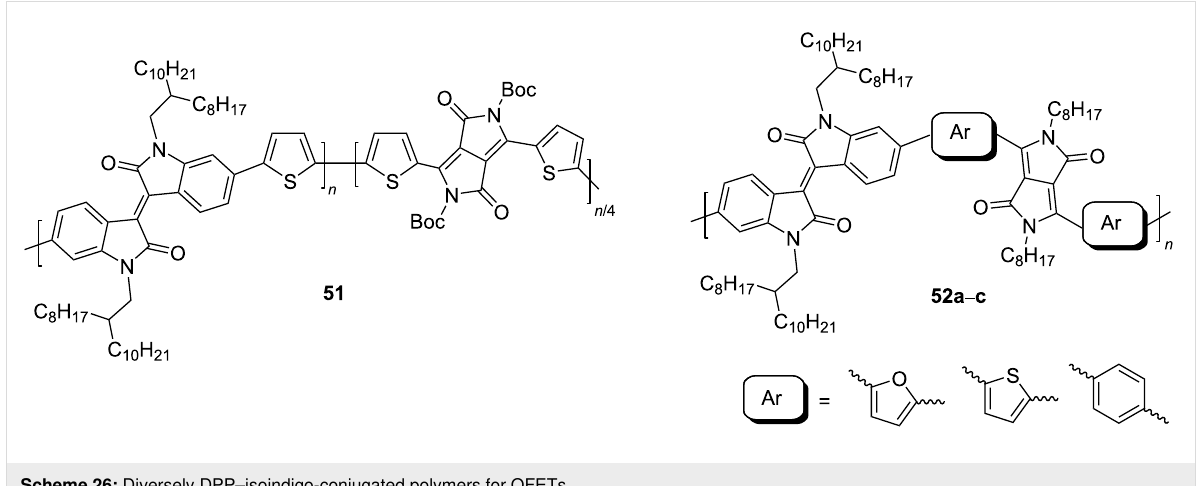
nificant improvement of the semiconducting properties of an isoindigo polymer can be achieved by “multifluorination”, the introduction of fluorine atoms both to the dithiophene fragment and to the 7,7'-positions of isoindigo (compound 50 ) [88]. As such, the presence of fluorine atoms led to the ambipolarity of the polymer with an effective ratio μ h / μ e = 3.94 cm 2 ⋅ V − 1 ⋅ s − 1 / 3.50 cm 2 ⋅ V − 1 ⋅ s − 1 . Recently, diketopyrrolo[3,4- c ]pyrrole (DPP) derivatives, which are highly conjugated electron-withdrawing heterocycles with high charge conductivity, broad absorption spectrum, photosta- bility, and thermal stability have attracted considerable interest of researchers in the field of organic electronics [92-94]. Isoindigo derivatives have similar characteristics. Taking into